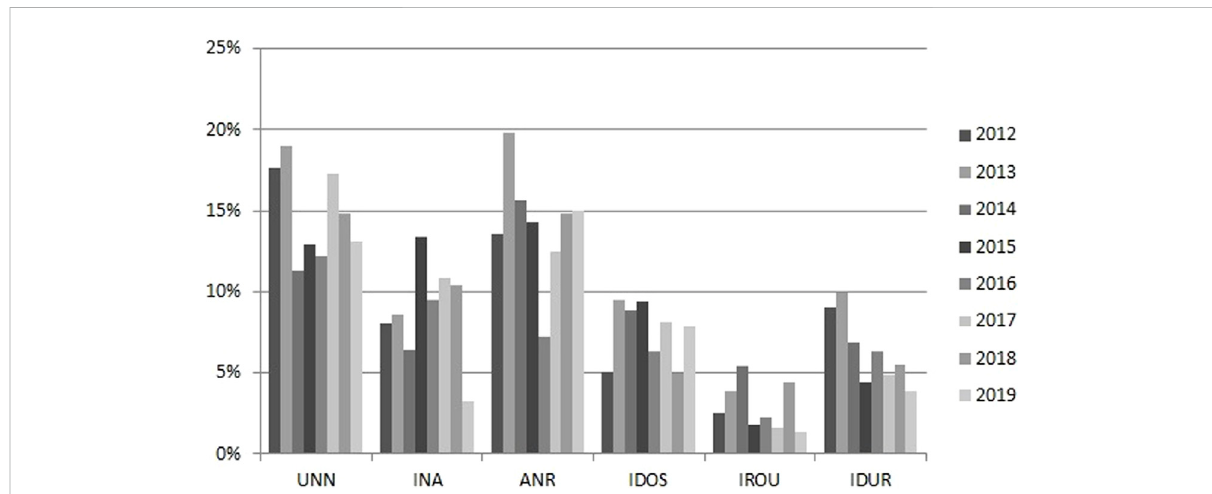
FIGURE 1 Speci fi creasonsforwhichtheantimicrobialprescriptionswereevaluatedasinappropriateperstudyyear.Inappropriateprescriptionsweresub- classi fi edinto “ unnecessary ” (UNN), “ inadequate ” drug(INA)accordingtosusceptibilitytestingorlackofcoverageforthemainetiologicalpathogens for the speci fi c syndrome, “ adequate but not recommended ” (ANR) if the drug chosen was adequate considering the spectrum, dose, route and duration but it was not the fi rst option recommended by the guideline without any reason for not using the fi rst option (this was considered a marker of the guideline adherence), “ inadequate dose ” (IDOS), “ inadequate route ” (IROU) and “ inadequate duration ”